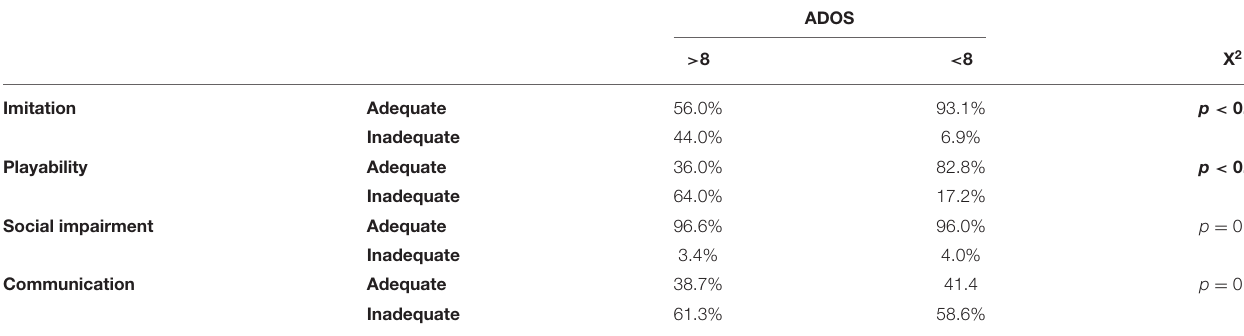
TABLE 5 | Frequency of results in percentage, by a total of ADOS in the second moment of